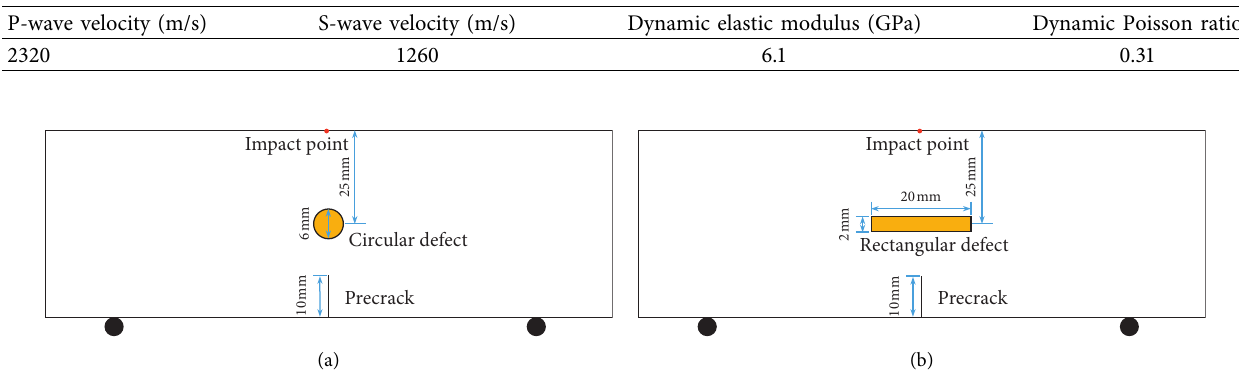
Figure 3: The experimental system of digital laser dynamic caustics. Table 1: Dynamic mechanical parameters of PMMA.